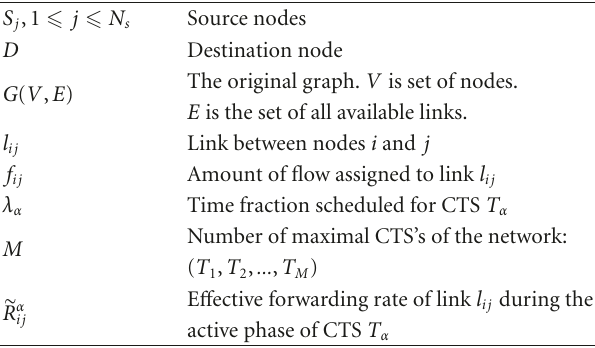
Table 1: Notation on Linear Programming